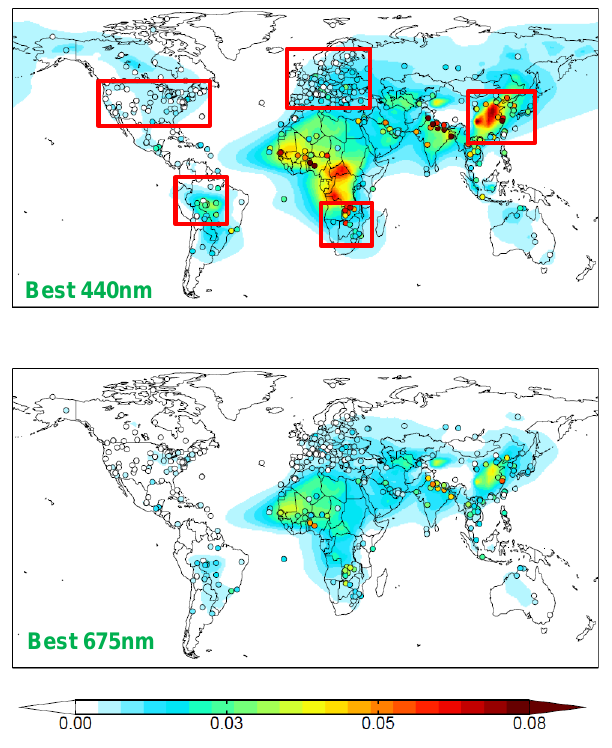
Figure 7. The annual mean simulated AAOD at 440nm (upper) and 670nm (lower) from the “best” simulation. The circles indicate the 12-year average observed AAOD at AERONET sites. The red boxes in the upper figure show the analysis regions discussed in Sect. 5 and shown in Fig.